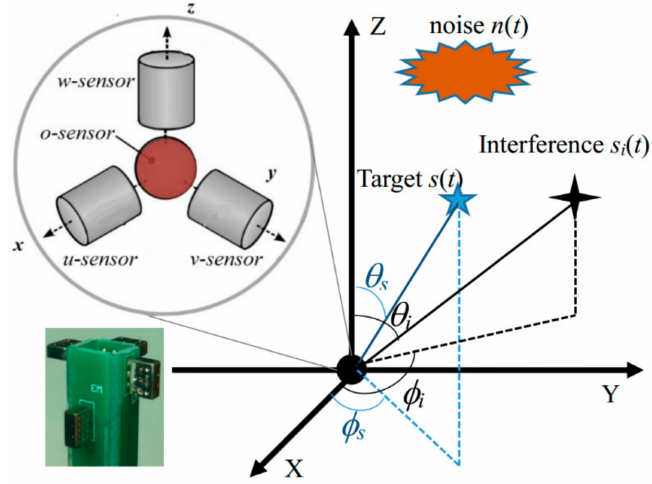
Figure 1. Illustration of a single acoustic vector sensor (AVS) for data capturing.